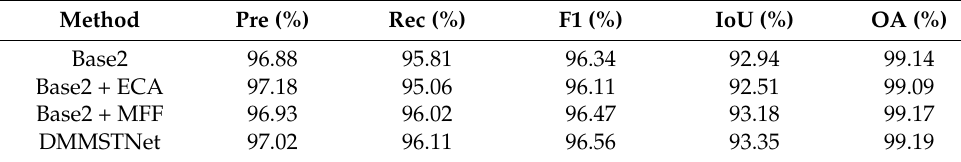
Table 4. Numerical Ablation Base1 Results on CCD Dataset. Table 6. Numerical Ablation Base2 Results on CCD